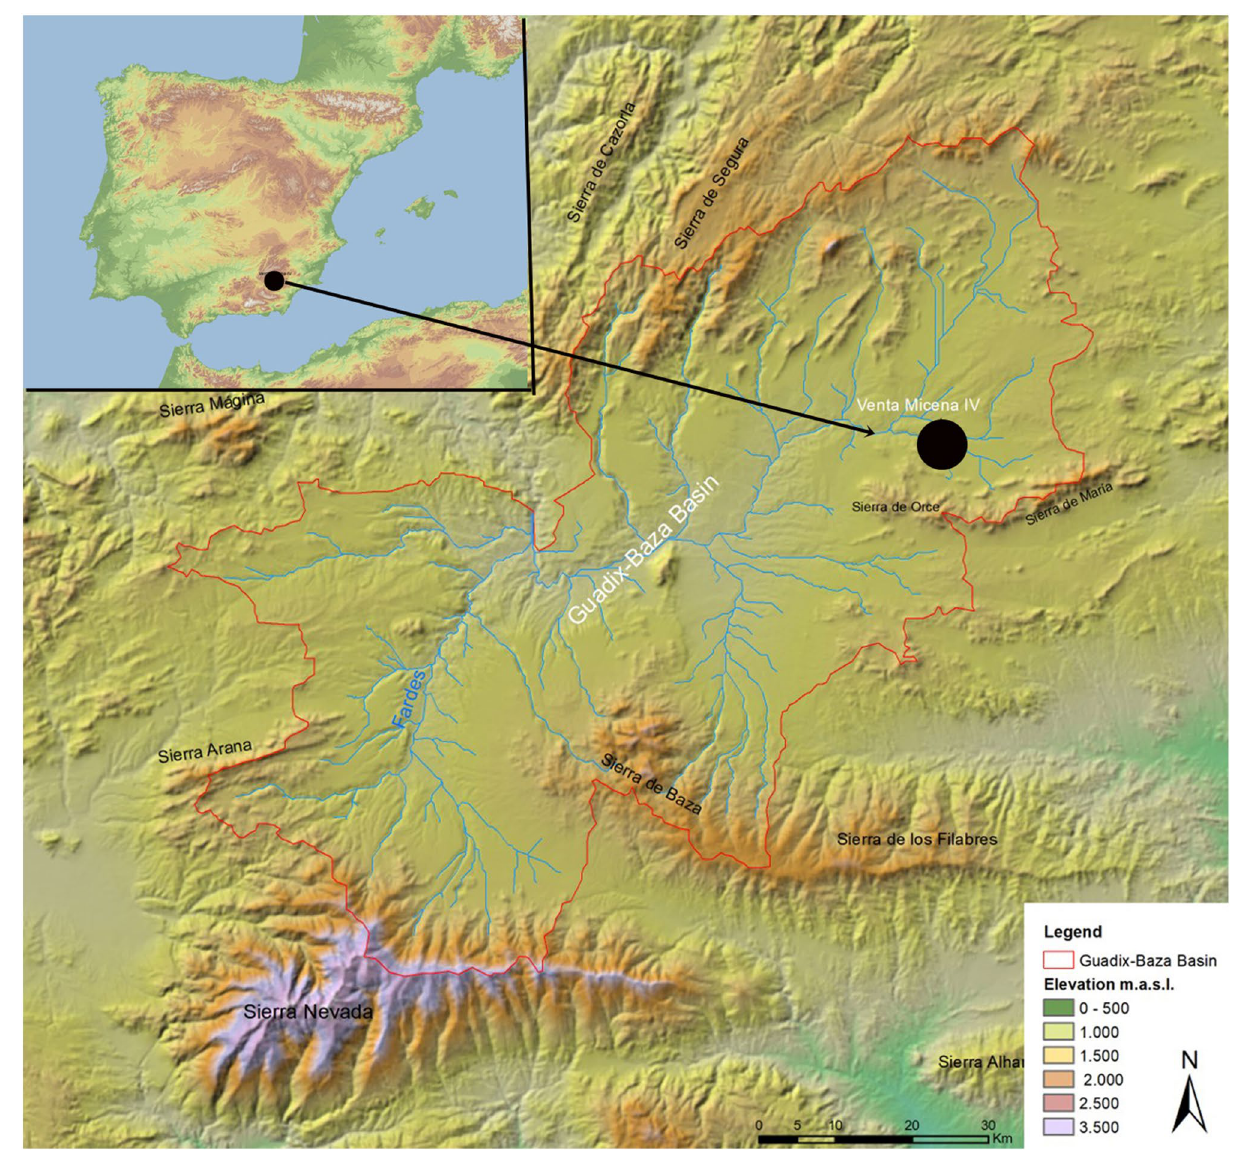
Figure 1. Geographic and topological location of Venta Micena